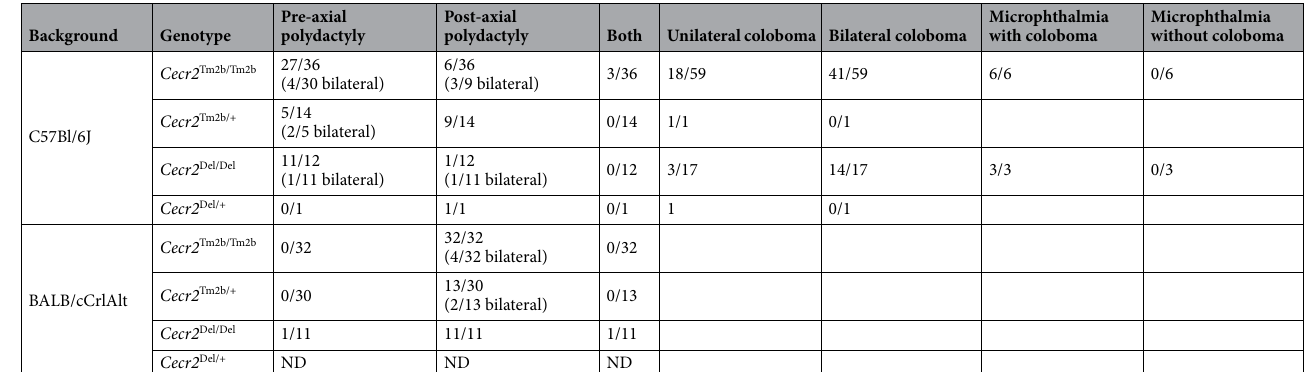
Table 2. Penetrance of polydactyly and eye defects in detail of the Cecr2 Tm2b and Cecr2 Del mutations on 2 genetic